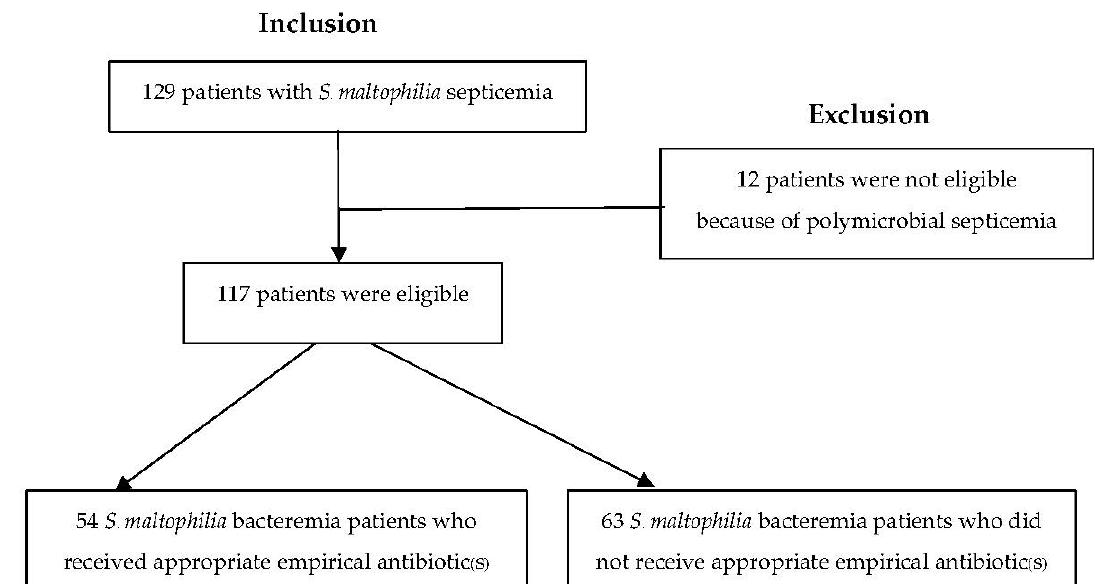
Figure 1 . Study enrollment flow chart . Figure 1. Study enrollment flow chart. Only 54 (46.2%) patients received appropriate empirical antimicrobial agents, whereas 63 (53.8%) received inappropriate empirical antimicrobial agents. The majority of patients (94%) received empirical antibiotic therapy with carbapenem, which is ineffective against S . maltophilia , whereas one-third (34%) received empirical antibiotic treatment with colistin, and only one-fourth had received TMP-SMX or fluoroquinolone for empirical therapy. The duration of antibiotic treatment did not differ between the two groups.